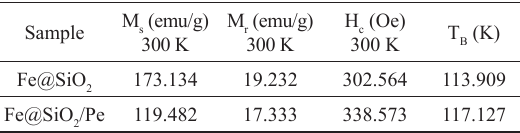
Table 2. Magnetic parameters, saturation magnetization (M coercivity (H ), and blocking temperature (T c